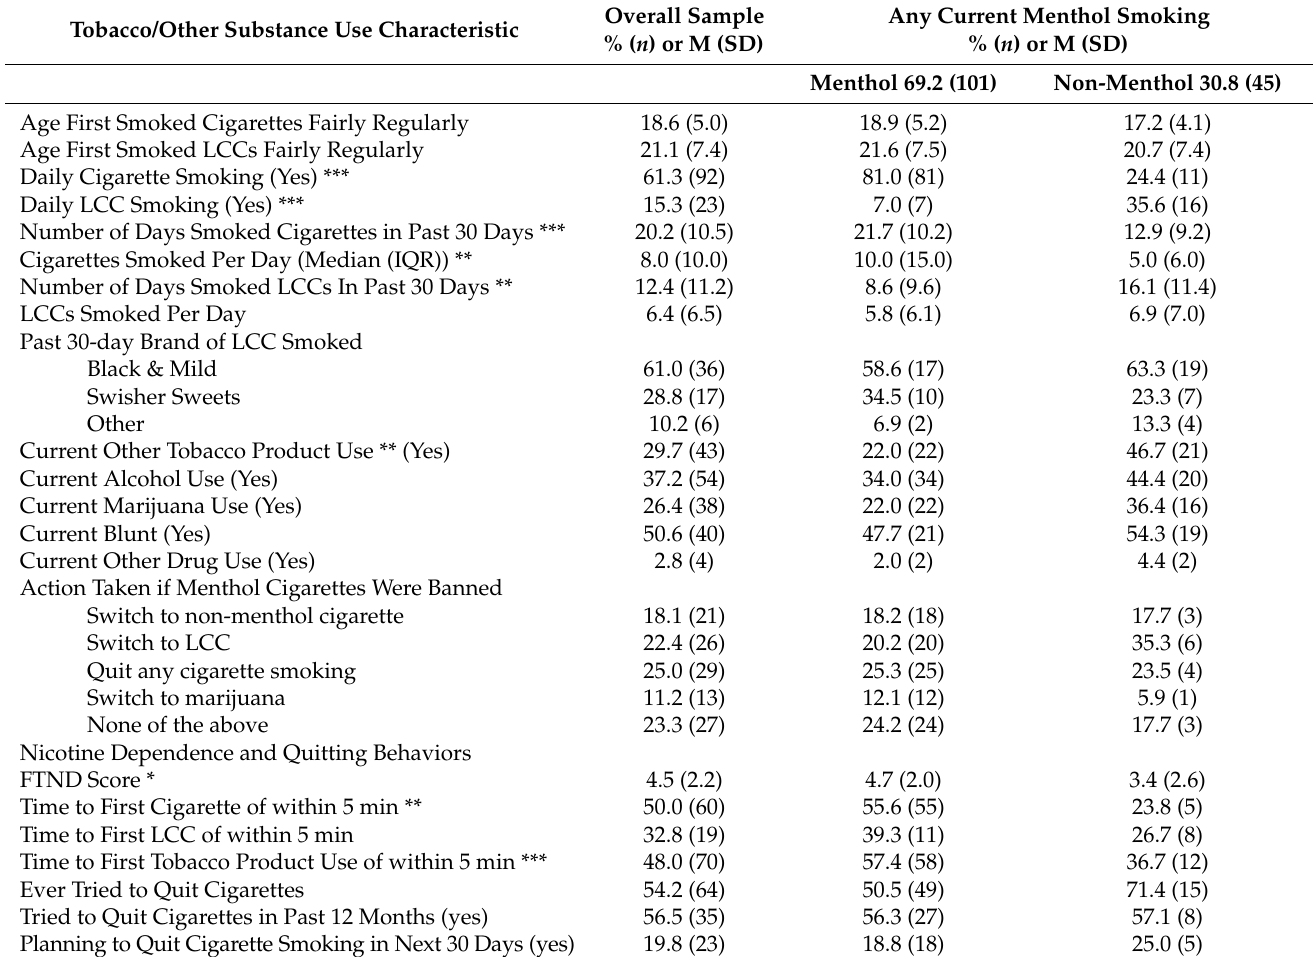
Table 2. Smoker and Other Substance Use Characteristics by Menthol Smoking Status ( n =